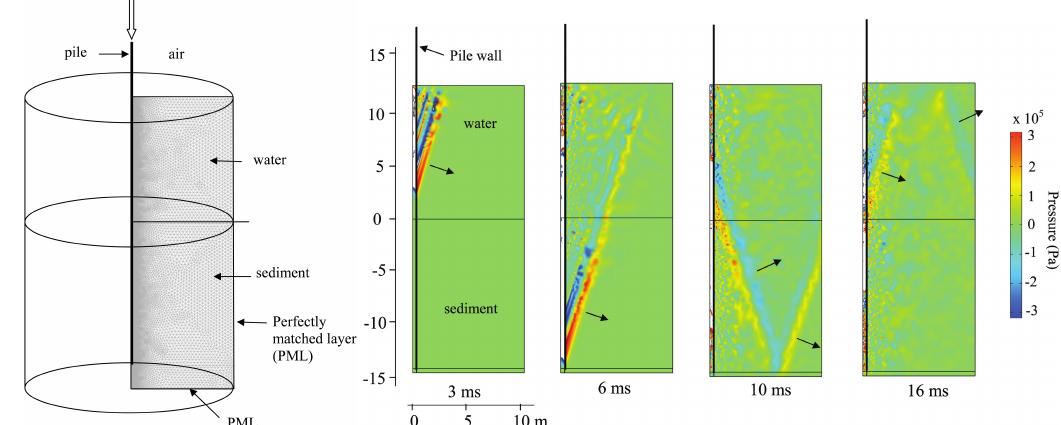
Figure 2. Axisymmetric FE model of pile and water ( left ). Acoustic pressure surface plots showing the acoustic radiation from the pile at 3, 6, 10 and 16 ms after impact by pile hammer. The propagation direction of the wave front associated with the Mach cones produced in the water and the sediment is indicated by the arrows ( right ). Reprinted with permission from Reinhall, P.G., Dahl, P.H.